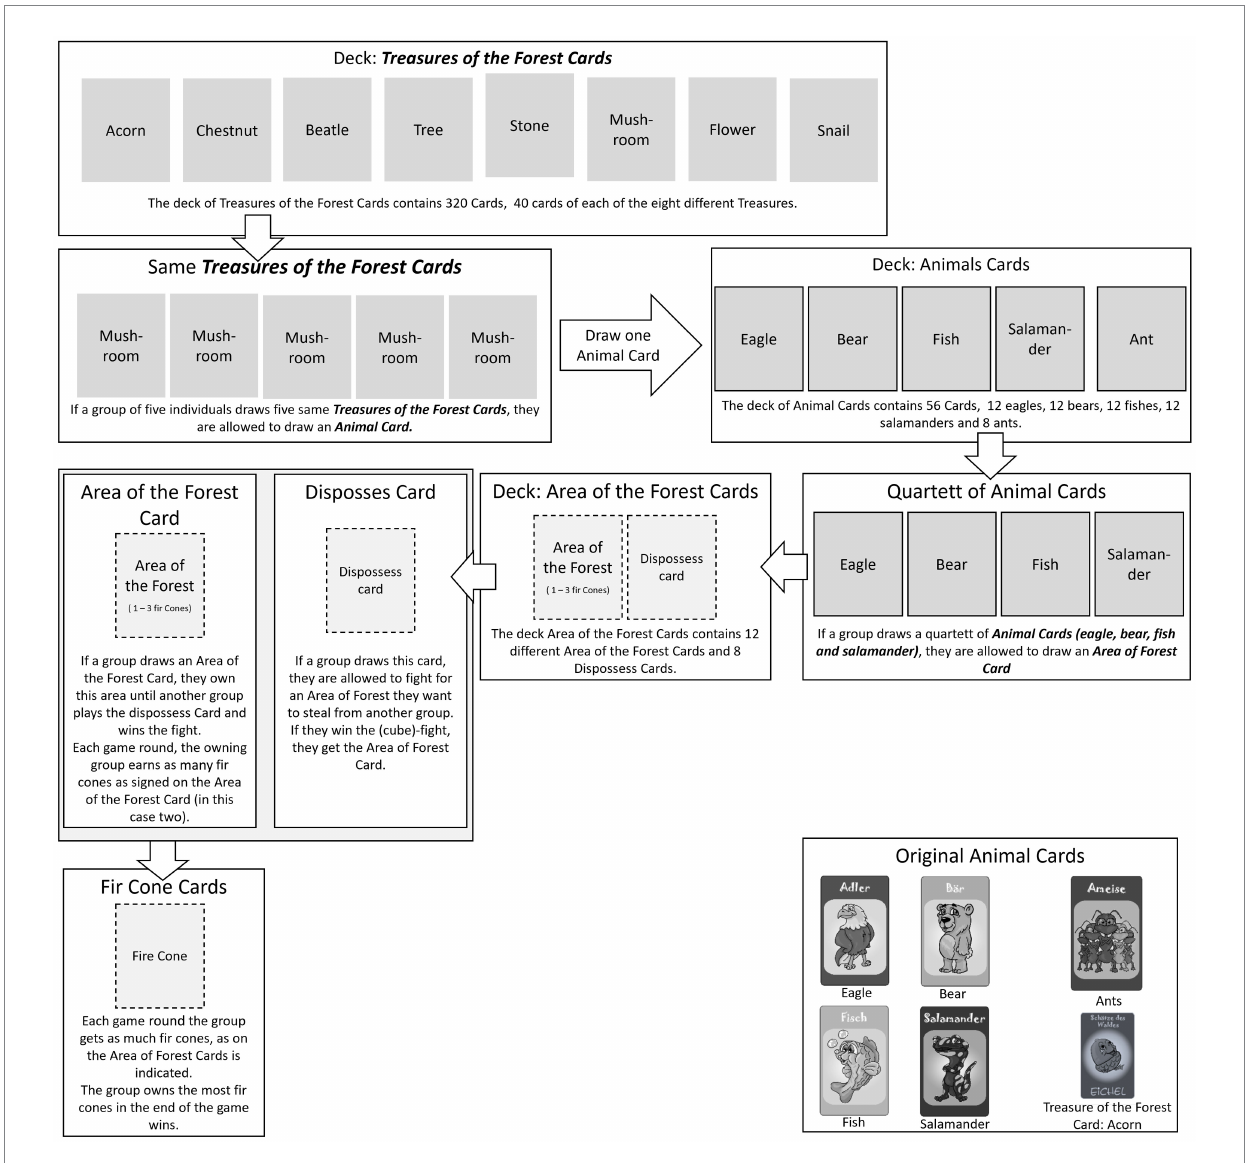
FIGURE 1 Mechanics of the game team of animals for original cards.